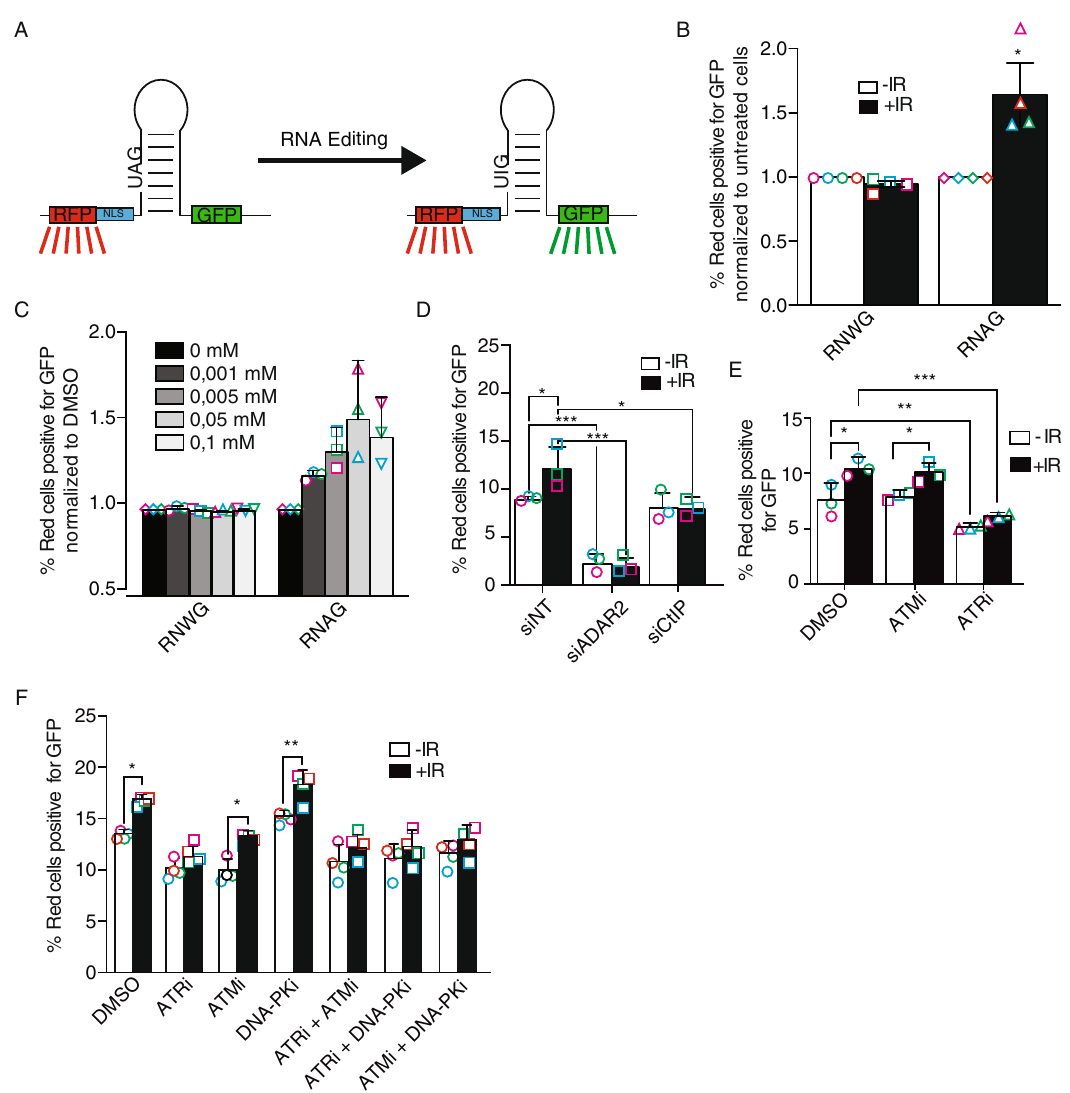
Fig. 1 DNA damage increases RNA editing. A Scheme of the RNAG editing system. A bi-cistronic mRNA containing the RFP and GFP sequences is produced. The presence of a stop codon impedes the expression of the GFP ORF, except when the adenine is edited to inosine. The presence of a secondary structure containing such stop codon allows its recognition and deamination of the adenine by ADAR proteins. B DNA damage-induced RNA editing. The plot shows the percentage of cells bearing the RNAG reporter or the constitutively edited RNWG system that express both the RFP (red cells) and GFP (green cells). Cells were either irradiated ( + IR; 10 Gy; black bars) or mock-treated ( – IR; white bars) and incubated for 12 h. The percentage of green cells over 10.000 red cells were analyzed on BD FACSAriaTM using FACSDiva v5.0.3 software. For each reporter, the ratio of green and red cells was normalized with the untreated conditions. Statistical signi fi cance was determined with a two-tailed paired Student ’ s t -test. C Same as B , but cells were treated with the indicated concentration of camptothecin (CPT). D Cells bearing the RNAG reporter were transfected with the indicated siRNAs and irradiated or not, and the percentage of red cells that were also green is plotted. Statistical signi fi cance was determined with a two-way ANOVA. E Same as D , but cells were pretreated for 2 h with 10 μ M of inhibitors of ATM (ATMi), ATR (ATRi), or DMSO as control, previous to the irradiation. Cells were collected to check for editing levels 10 h after irradiation. The inhibitors were kept for the duration of the experiment. Statistical signi fi cance was determined with a two-way ANOVA. F Same as E , but, cells were also treated with DNA – PK inhibitor (DNA – PKi), as well as the double combinations of the ATM, ATR, and DNA – PK inhibitors, as indicated. Statistical signi fi cance was determined with a two-way ANOVA. The average and the standard deviation of the medians of four (panels B and F) or three (panels C – E) independent experiments are shown. Each individual replica is marked with a colored symbol. One, two, or three asterisks represent p < 0.05, p < 0.01, or p < 0.001, respectively. Actual p -values can be found in the Source data fi le. Only biological relevant comparisons are experiment with ATM, ATR, and DNA-PK inhibitors in different inhibition decreased the DNA damage-induced editing increase combinations (Fig. 1F). As shown, inhibition of ATR suppressed (Fig. 1E). This agrees with the notion that ATR and CtIP act on the DNA damage-induction of RNA editing, regardless of the the same branch of the DNA damage checkpoint in response to presence of the inhibitors of ATM or DNA-PK. Interestingly, DSBs 29 . The lack of response with the ATM inhibitor could be explained by a compensation by another member of the PIKK chemical inhibition of DNA-PK showed a limited increase in the family, most likely DNA-PK. Along those lines, the ATR effect basal levels of RNA editing, but importantly the exposure to DNA could also be affected by this phenomenon. Thus, we repeated the damage still provoked a hyperactivation of the process. Notably,